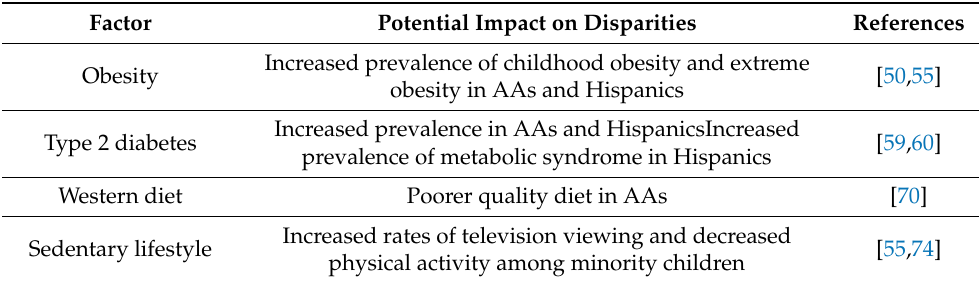
Table 2. Potential environmental risk factors for early-onset colorectal cancer and how these could contribute to disparities by